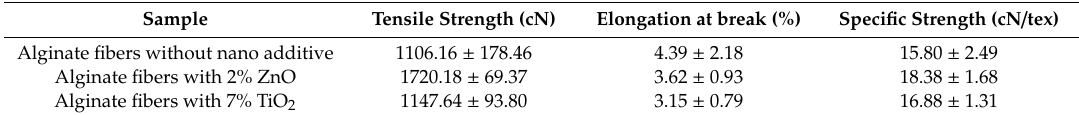
Table 3. Mechanical properties of obtained